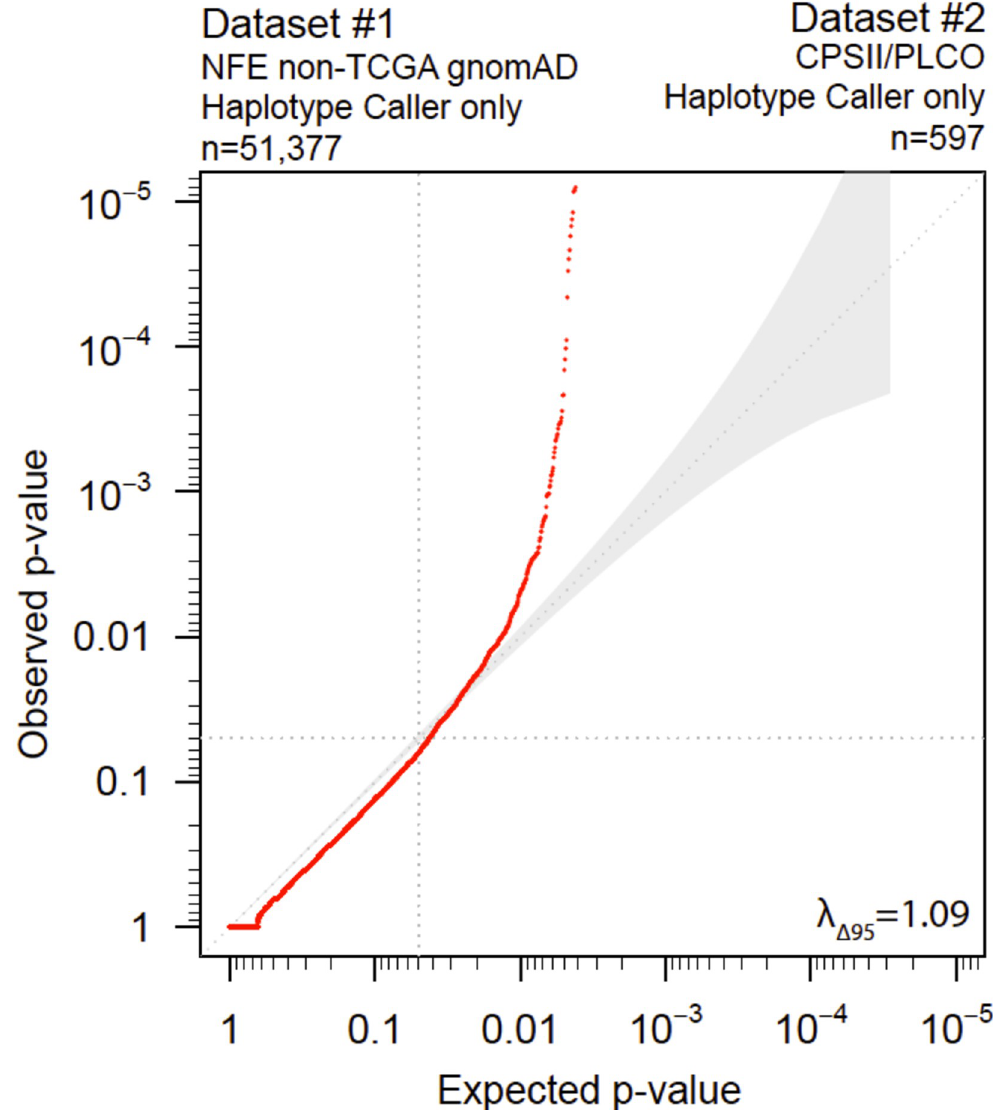
Fig 1. Demonstration of increased false-positive findings with expected-null findings using public controls. Quantile- quantile plot (synonymous variants only) of non-Finnish European non-TCGA (The Cancer Genome Atlas) gnomAD (serving as a public control) versus an experimental dataset. We observed highly inflated p-values deviating from the 95% confidence